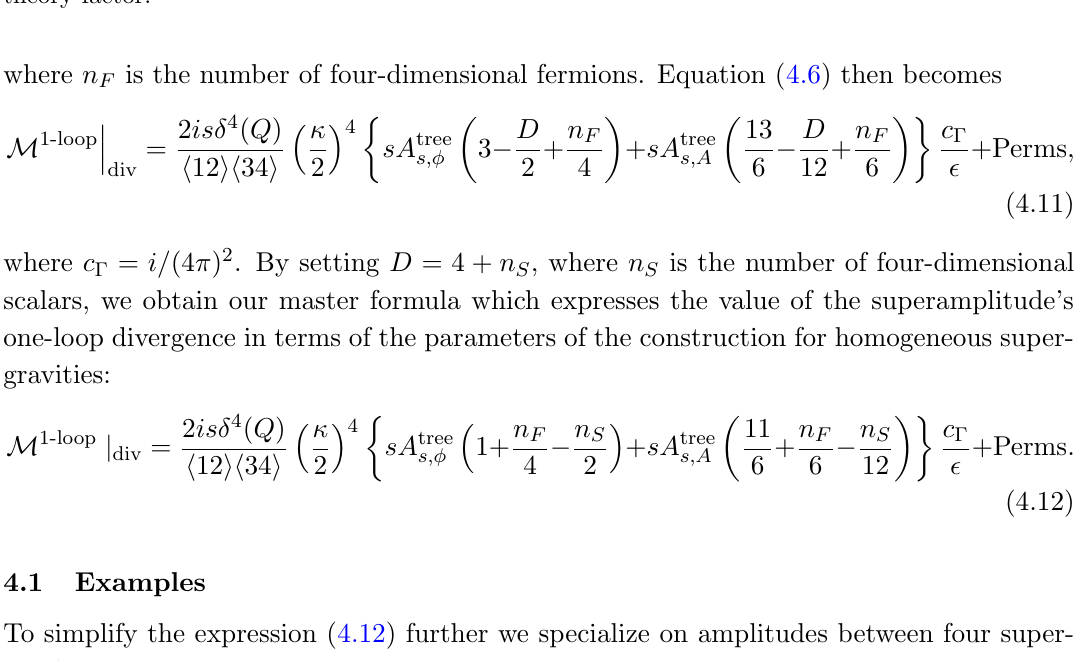
Figure 2 . Bubble Feynman diagrams used in the computation for the non-supersymmetric gauge- theory